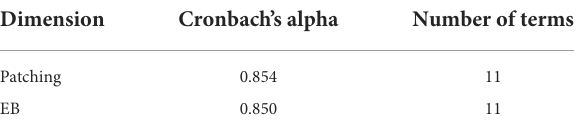
TABLE 3 Reliability test